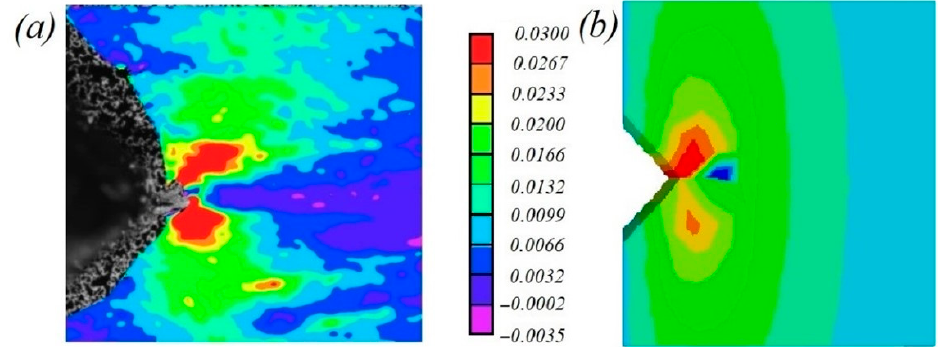
Figure 16. ( a ) Axial strains obtained using micro-DIC for heat-treated sample with horizontal orientation at maximum load value; ( b ) FE analysis performed in Abaqus CAE for same load.